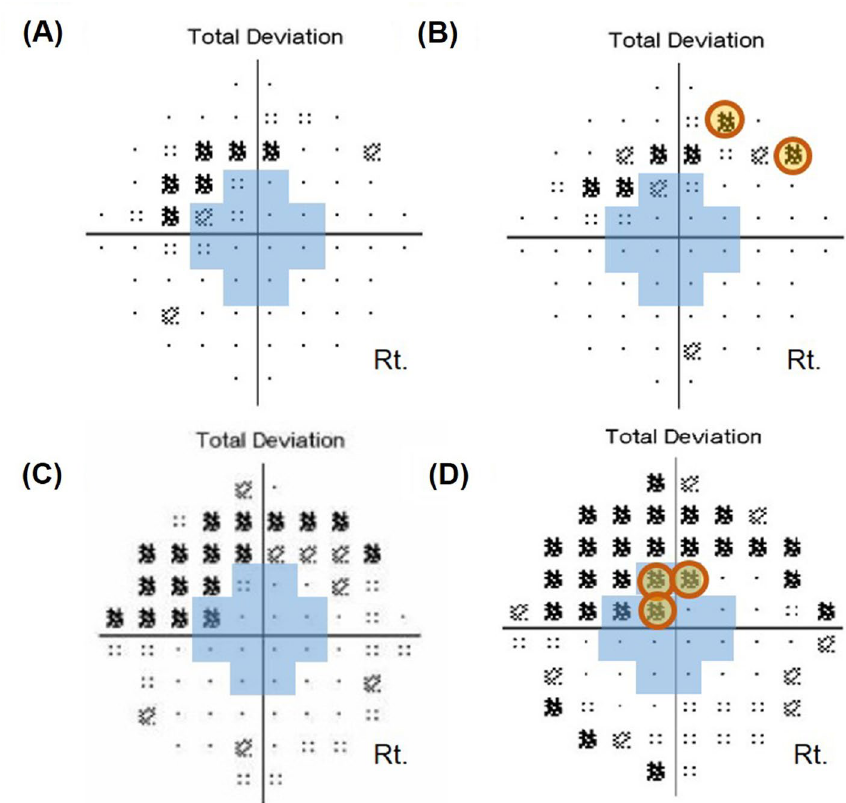
Figure 1. Classification of progression of initial paracentral scotomas according to location on the 10-2 visual field (VF) test. ( A ) and ( B ) Compared to outermost 10-2 VF progression, ( C ) and ( D ) three or more new contiguous points (5%, 5%, and 1% or 5%, 2%, and 2% depressed from normative database) in the central 12 points on 10-2 VF were considered as innermost 10-2 VF progression.